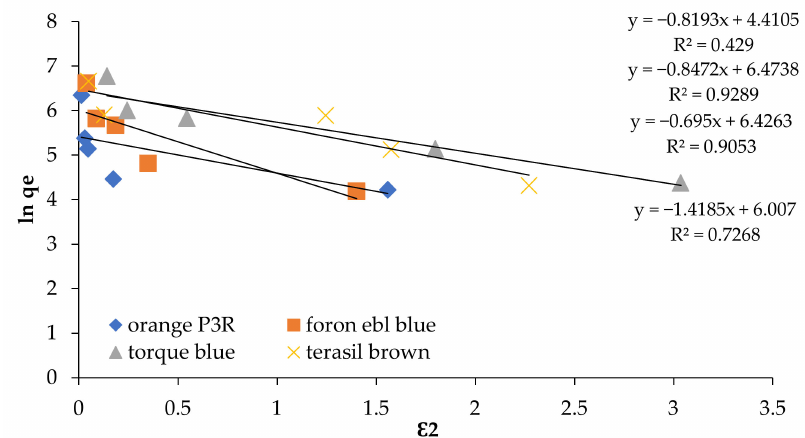
Figure 7. Dubinin Radushkevich Isotherm at 5 concentrations for non-calcinized composite.